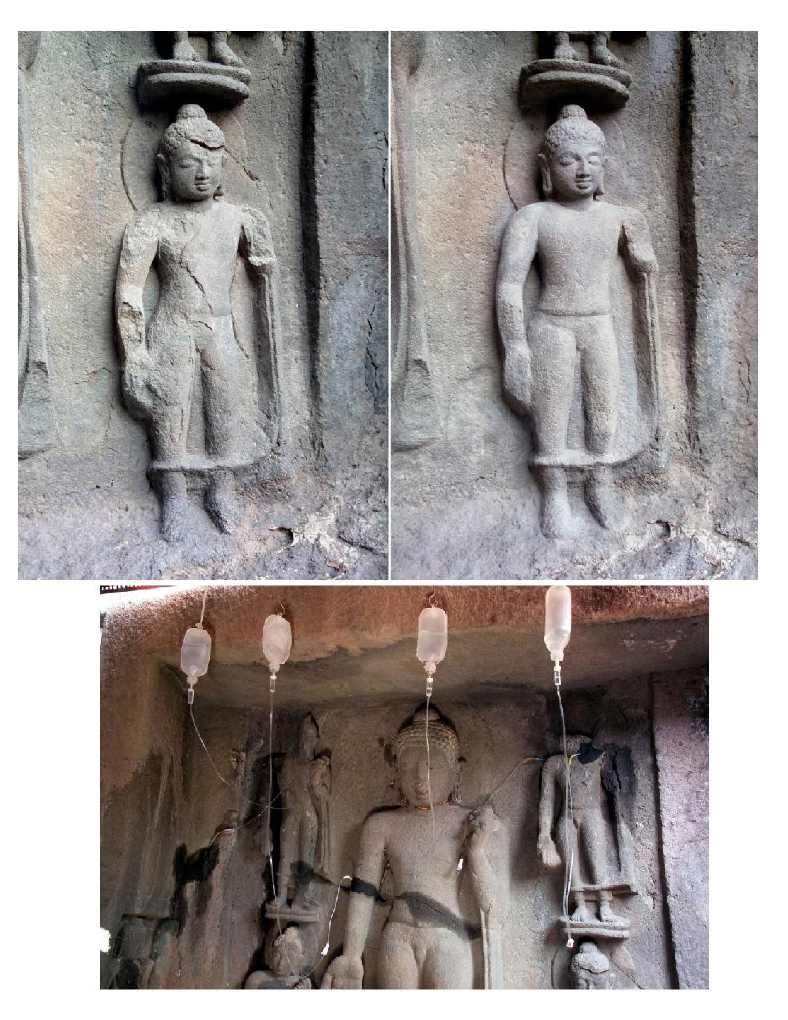
Figure 15. Consolidation of sculptures of Ajanta using ethyl